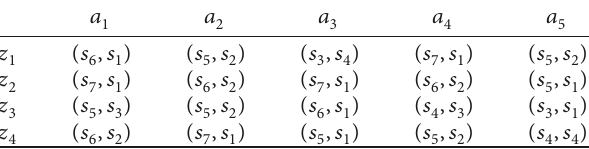
Table 12: Decision matrix R